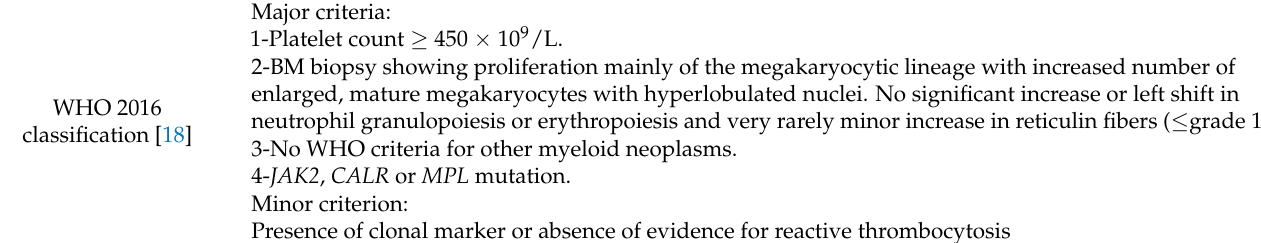
Table 3. Classification criteria for ET